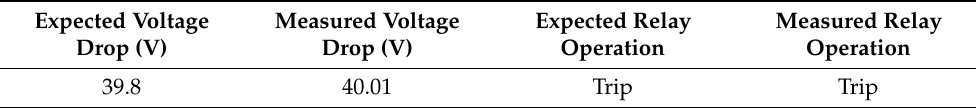
Table 7. Results comparison for the unstable condition.